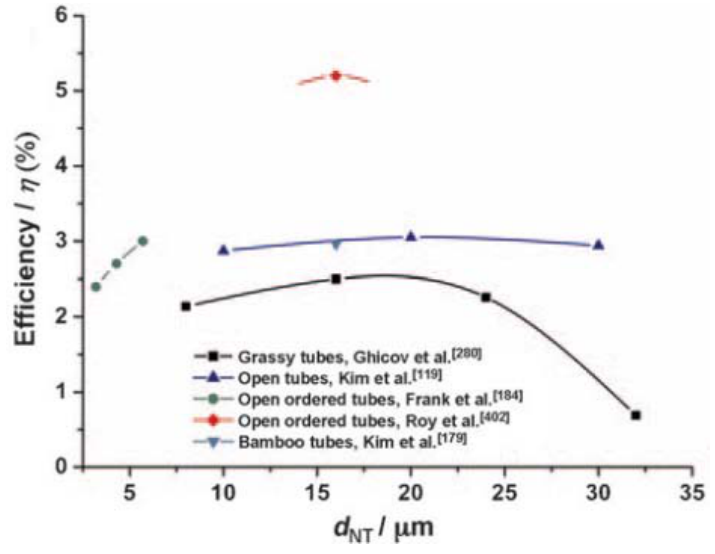
Figure 7. Effect of the length of nanotubes in dye-sensitized solar cells (DSSCs) on the solar power conversion efficiency. Reprinted with permission from